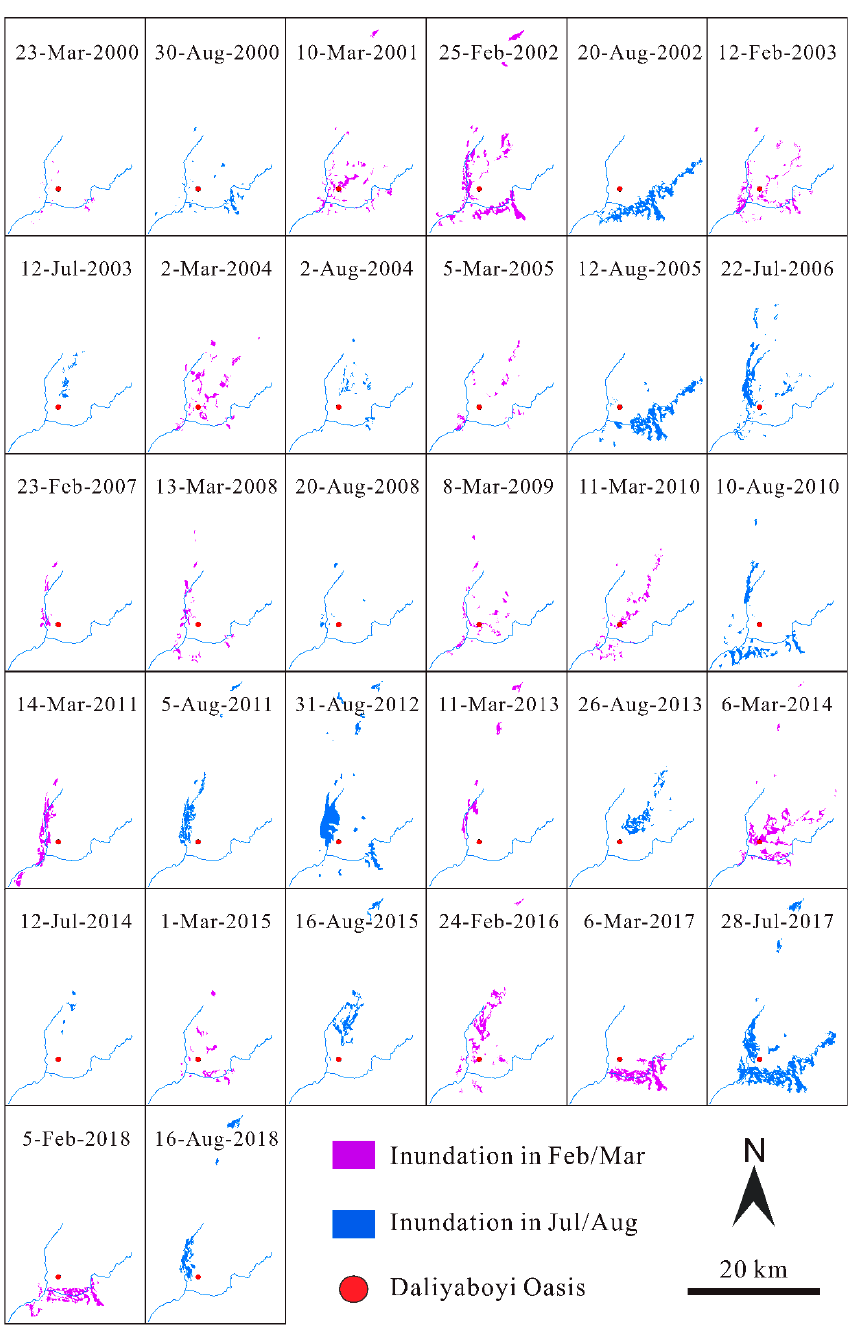
Figure 7. Variations in the spatial distribution of inundated areas within the Daliyaboyi Oasis dur- ing the peak period (February/March and July/August) from 2000 to 2018. the peak period (February/March and July/August) from 2000 to